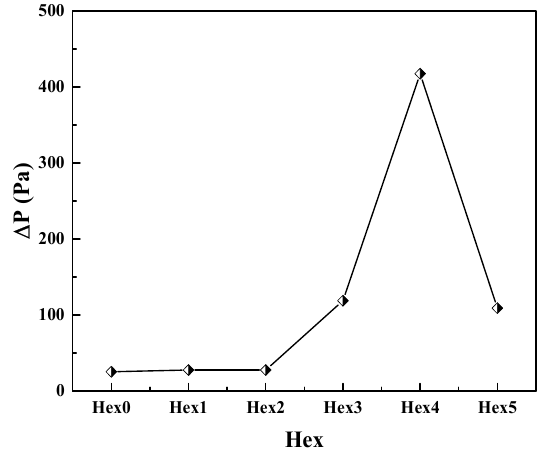
The pressure drops of Hex0~Hex5 at the inlet and the outlet of antifreeze are shown in Figure 12. The pressure drop of Hex5 with the internal channel A4 is the largest because its fin wave height is the smallest. The pressure drop of Hex4 is about 420 Pa. The pressure drops of Hex0, Hex1 and Hex2 are about 25 Pa. The pressure drops of Hex5 and Hex3 are 116 Pa and 106 Pa, respectively. Therefore, the pressure drop of the OSF structure is the smallest.